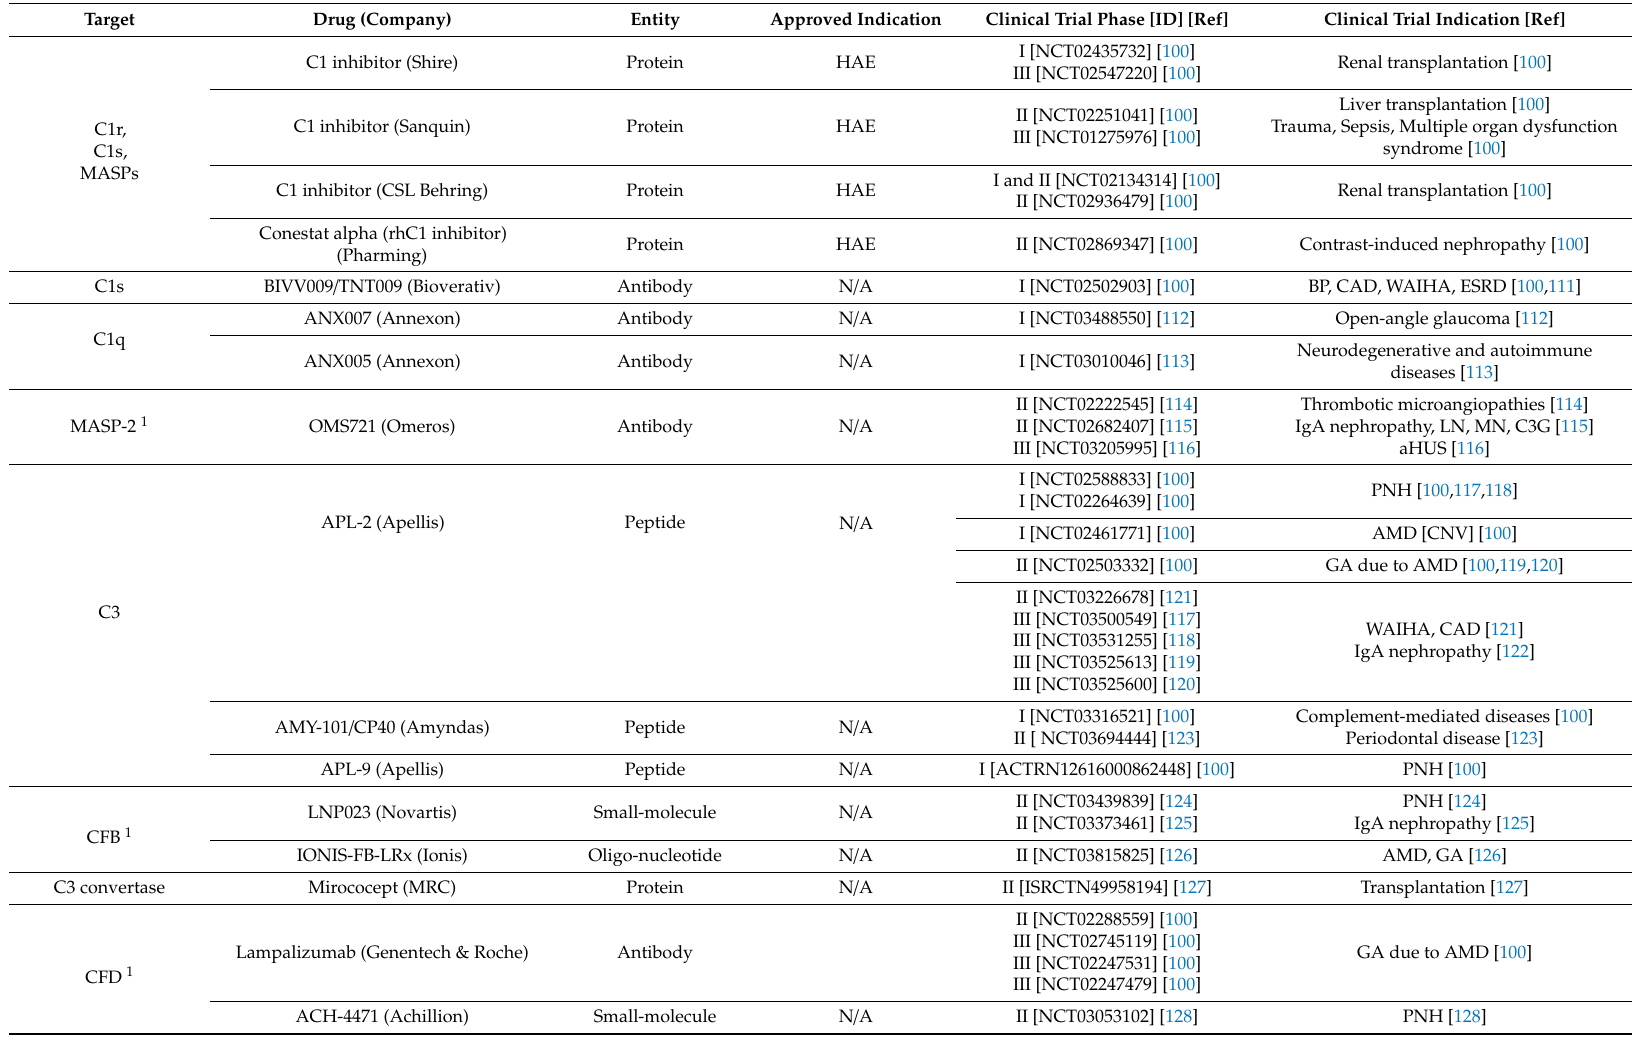
Table 1. Complement-targeted therapeutic compounds that have entered clinical